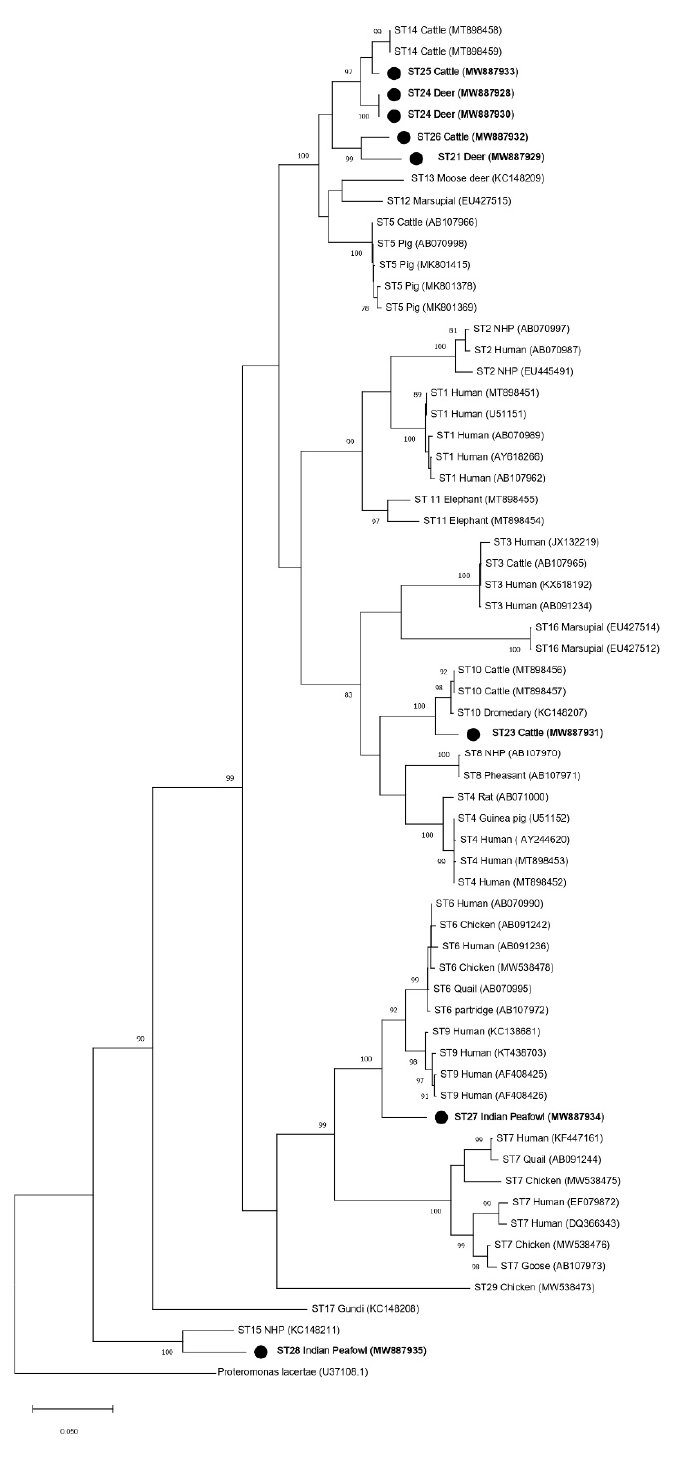
Figure 2. Phylogenetic relationships among Blastocystis full-length SSU rRNA gene nucleotide sequences generated in the present study (represented with a black filled circle) and representative reference sequences of the accepted subtypes (Table 2). Proteromonas lacertae was used as outgroup taxon to root the tree. Analysis was conducted by a maximum likelihood method. Genetic distances were calculated using the Kimura two-parameter model. This analysis involved 64 nucleotide sequences, and there were a total of 1953 positions in the final dataset. Bootstrap values lower than 75% are not displayed.